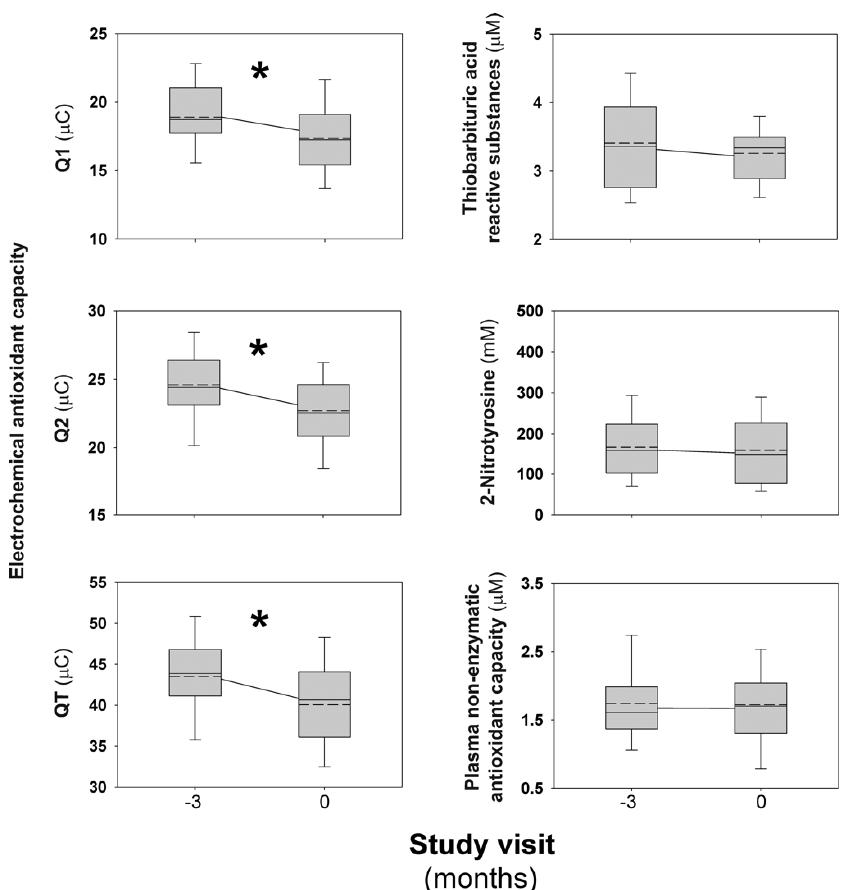
Figure 2. Short-term effects of combined oral contraceptive on oxidative stress biomarkers. The box indicates the 25th and 75th percentiles, the solid and short dashed lines within the box mark the median and mean, respectively. Whiskers below and above the box indicate the 10th and 90th percentiles. * Statistically significant change in mean values from month -3 to 0. Table 1. Baseline characteristics and fasting plasma redox status of the patients with functional hy- perandrogenism (PCOS or idiopathic hyperandrogenism) randomized to treatment with a com- bined oral contraceptive pill plus scheduled phlebotomies (experimental arm) or to COC plus ob- servation (control arm).